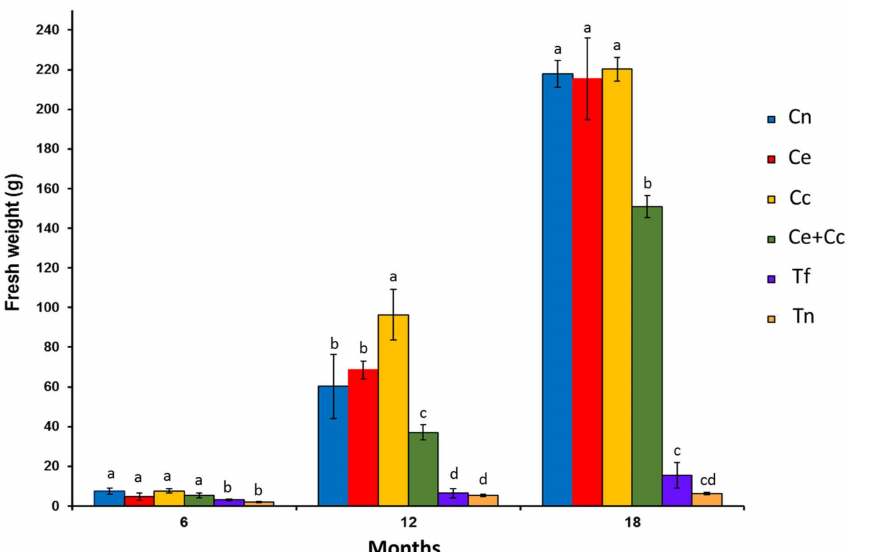
Figure 2. Fresh plant weight of Agave maximiliana at 6, 12, and 18 months after inoculation with arbuscular mycorrhizal fungi (AMF). Treatments: (1) consortium of autochthonous AMF of the A. maximiliana rhizosphere (Cn), (2) Claroideoglomus etunicatum (Ce), (3) Claroideoglomus claroideum (Cc), (4) C. etunicatum + C. claroideum (Ce + Cc), (5) control with fertilization and without mycorrhizal inoculation (Tf), and (6) control without fertilization or mycorrhizal inoculation (Tn). Age 6 months, n = 18; age 12 months, n = 13; age 18 months, n = 8. The bars represent the means ± standard error. An analysis of variance was followed by a means test ( p ≤ 0.05). Different letters (by age) indicate significant differences between treatments.